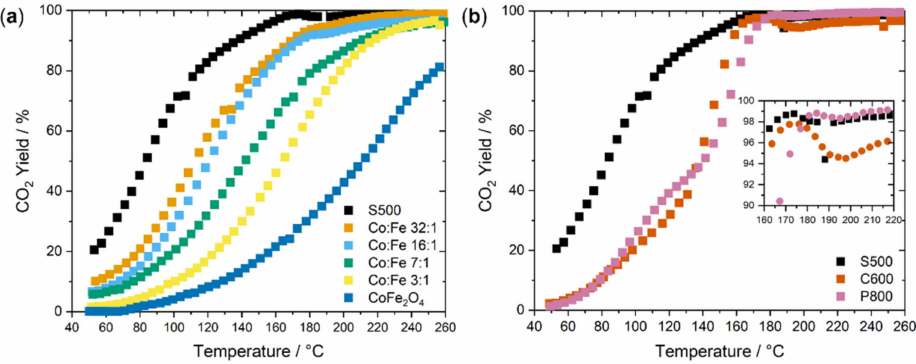
Figure 2. ( a ) Temperature-programmed CO oxidation activation of the SBA-15 templated pristine Co 3 O 4 , CoFe 2 O 4, and Fe incorporation series in the 1st run. ( b ) Temperature-programmed CO oxidation activity of the different Co oxide samples in the 1st